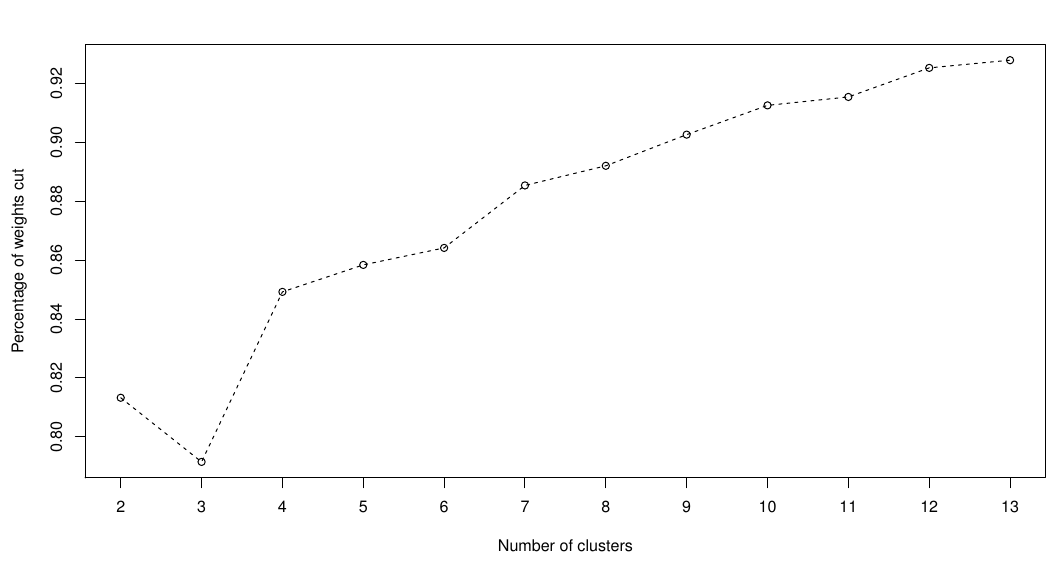
Figure 9. Percentage of weights cut against the number of clusters.